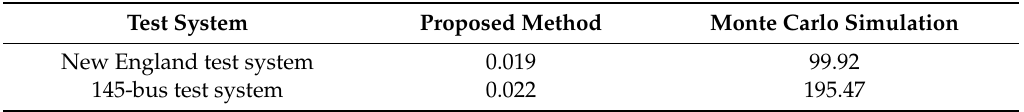
Table 3. Computational Time